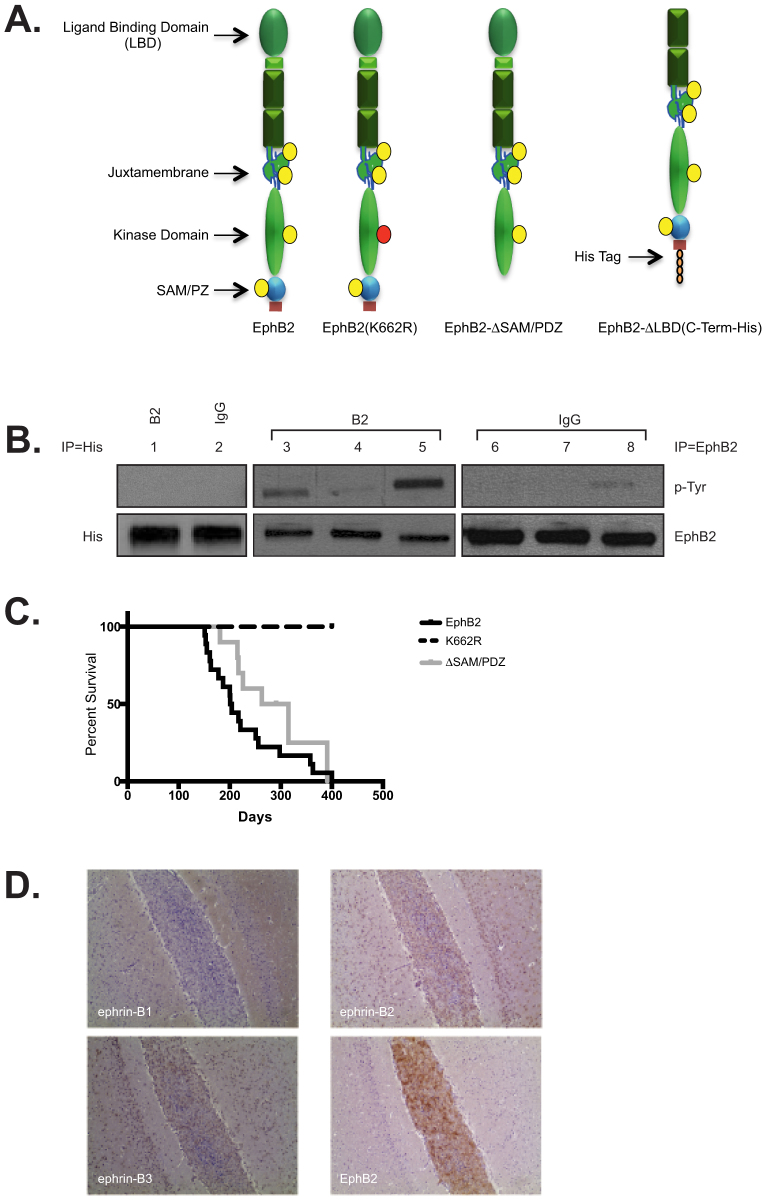
EphB2 activation is required for utNSCs transformation.(a) Structure of EphB2 mutant and domain deletion receptors. Yellow circle = Established phosphorylation site; Red circle = K662R mutation. (b) In vitro receptor activation assay of Ink4a/Arf(−/−) STeNSCs infected with retrovirus expressing EphB2 (lanes 3 and 6), EphB2- ΔLBD(C-Term-His) (lanes 1 and 2), EphB2(K662R) (lanes 4 and 7) or EphB2-ΔSAM/PDZ (lanes 5 and 8) incubated with ephrin-B2 (B2 lanes 1, 3–5) or anti-human-IgG (IgG lanes 2, 6–8). Lanes 1 and 2 were immunoprecipitated and immunoblotted for EphB2- ΔLBD(C-Term-His) using a His specific antibody. Lanes 3-8 were immunoprecipitated for EphB2 and immunoblotted for phospho-tyrosine (p-Tyr; top) or EphB2 (bottom). (c) Survival curve of mice intracranially implanted with Ink4a/Arf(−/−) STeNSCs retrovirally infected with EphB2 (n = 18; black), EphB2(K662R) (n = 7; dash) or EphB2-ΔSAM/PDZ (n = 10; grey). (d) Ephrin-B(1-3) and EphB2 immunohistochemical staining of mouse brain intracranially implanted with tdNSCs.